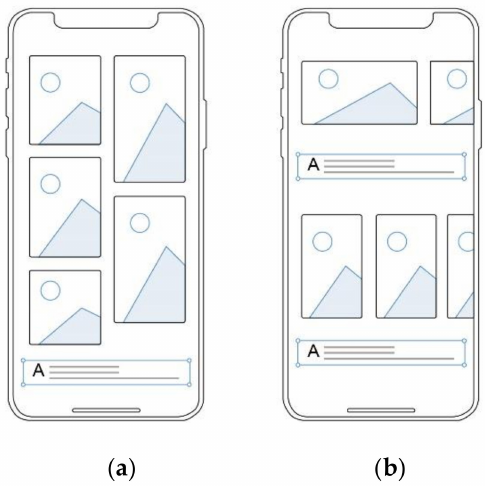
Figure 2. Examples of comics used for propagating the COVID-19 related protection knowledge (the text has been translated into English, and all texts are the same regardless of the emotional design): ( a ) Comics based on positive emotion design; ( b ) Comics based on negative emotion design; ( c ) Comics based on neutral emotion design.